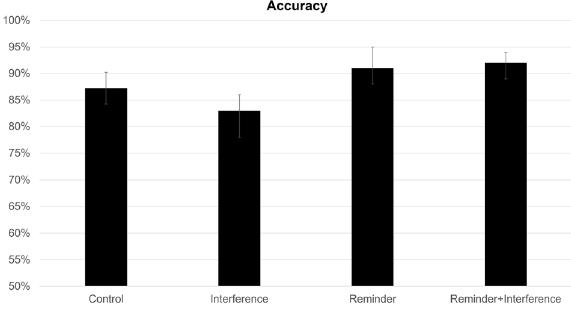
Fig. 1 Accuracy (%) for each condition of Experiment 1. Brackets represent 95% con fi dence